Question: Does the plotted quantity increase or decrease?
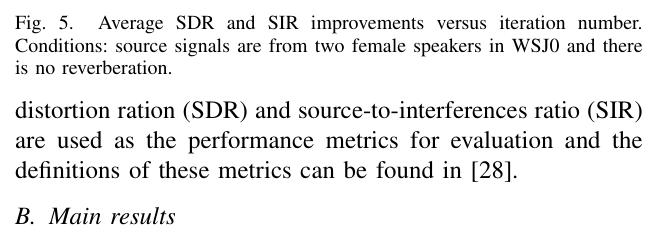
Answer: increasing